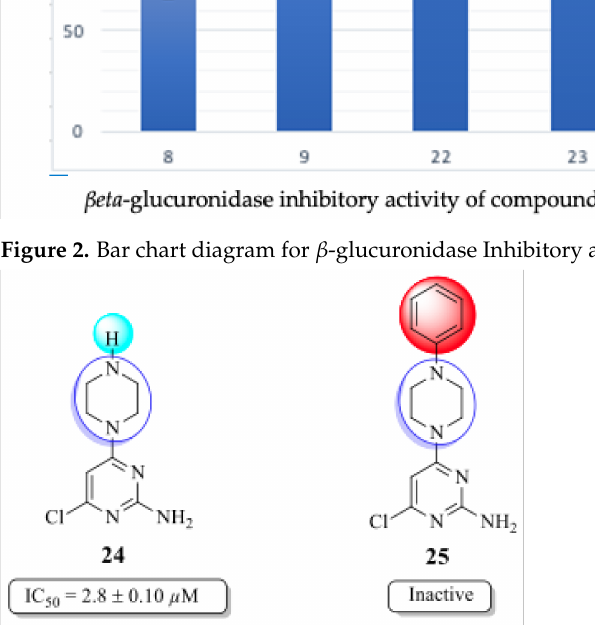
Figure 3. Comparison of in vitro β -glucuronidase inhibition potential of compounds having piper- azinyl and phenylpiperazinyl substitution at pyrimidine ring.